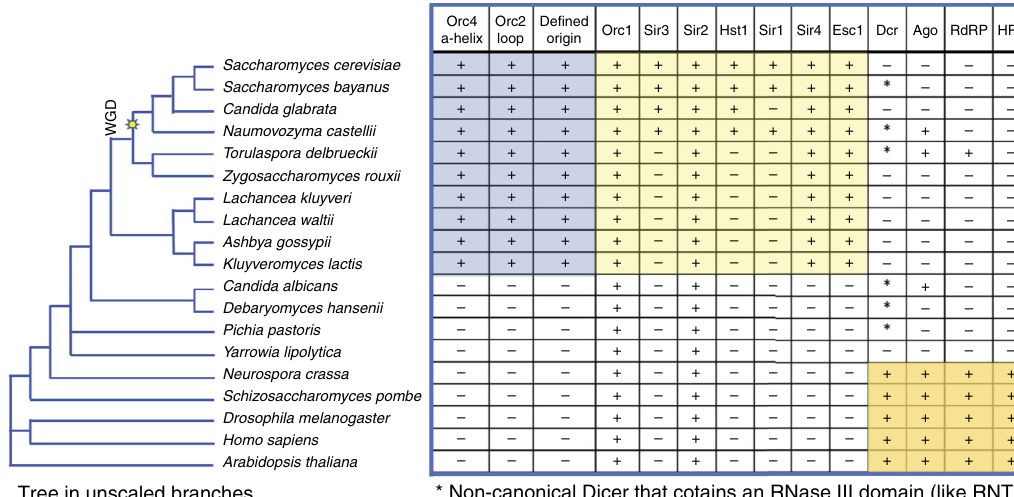
Fig. 5 Co-evolution of DNA replication origin speci fi cation and gene silencing. Phylogenetic tree is drawn based on whole genome vicinity and is in unscaled branches. The whole genome duplication (WGD) event is indicated in the tree. Table inspired by previous studies on gene silencing 30 . Positive symbol indicates the exist of genes, negative symbol indicates the absent of genes, asterisk symbol indicates exist of noncanonical dicer. Orange box: species that use RNAi for gene silencing. Yellow box: species that use ORC and Sir proteins for gene silencing. Blue box: species that have sequence speci fi c